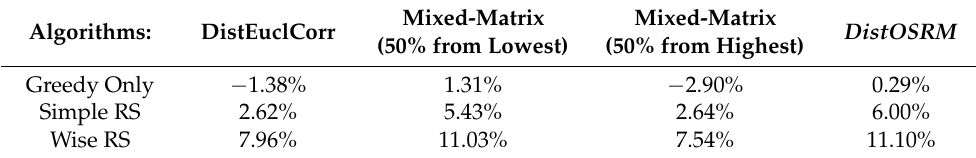
Table 1. Cost reduction for different distance matrix